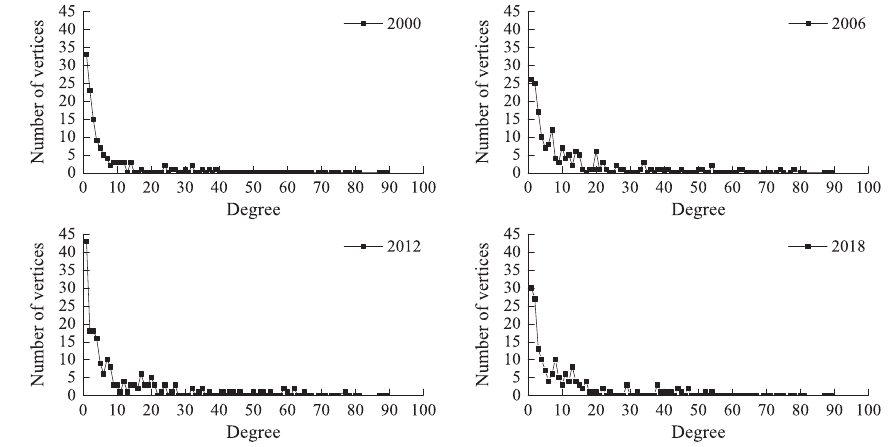
Figure 1. Degree distribution in 2002, 2006, 2010, 2014 and